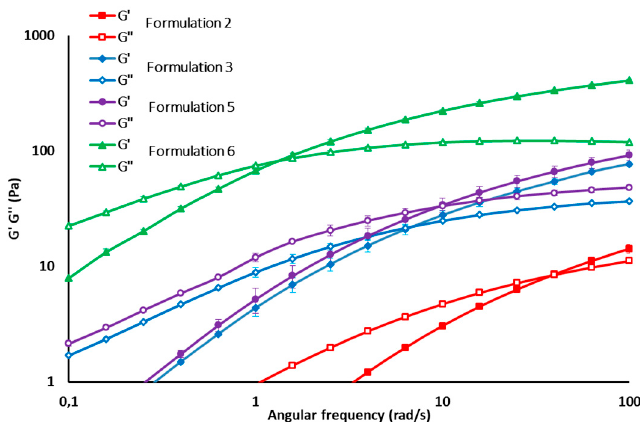
Figure 2. G’ and G” profiles of some HA formulations of the experimental design (mean values ± s.d., Figure 2. G’ and G’’ profiles of some HA formulations of the experimental design (mean values ±s.d., n = 3). n = 3).